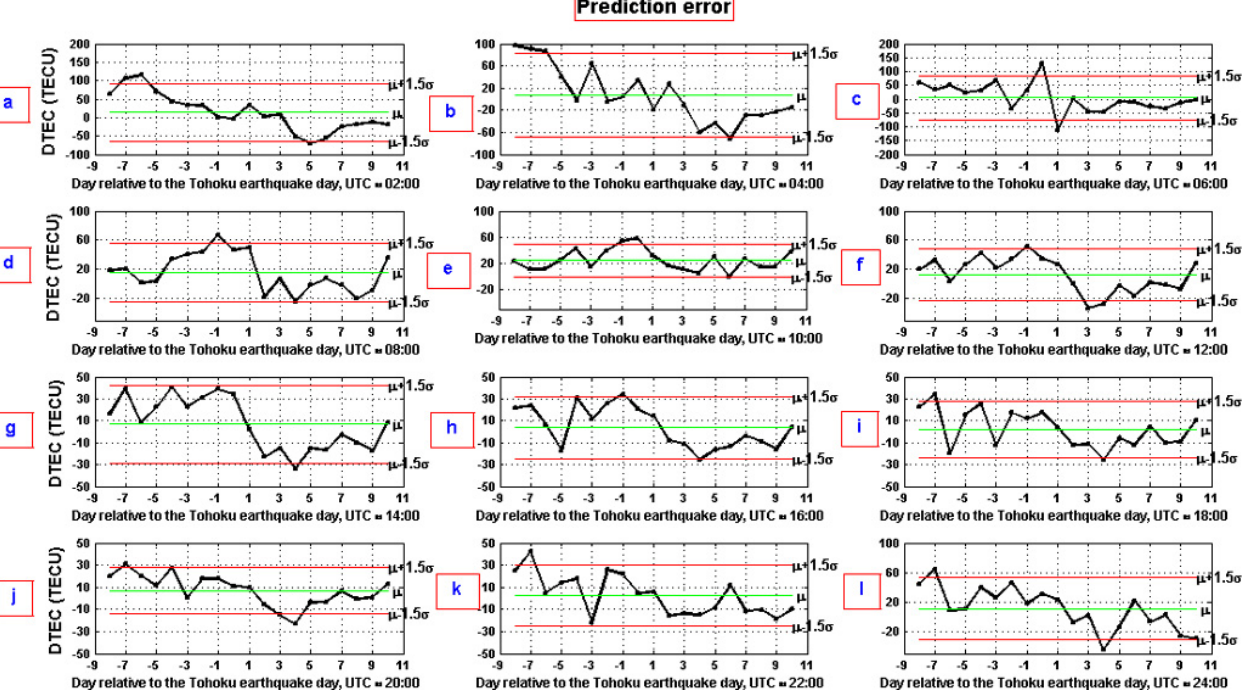
Fig. 3. Variations of the differences between the observed and the predicted values of TEC on days selected as testing set at different universal times. The red horizontal lines indicate the upper and lower bounds ( µ ± 1 . 5 × σ) . The green horizontal line indicates the mean value ( µ) . The x-axis represents the day relative to the Tohoku earthquake day.